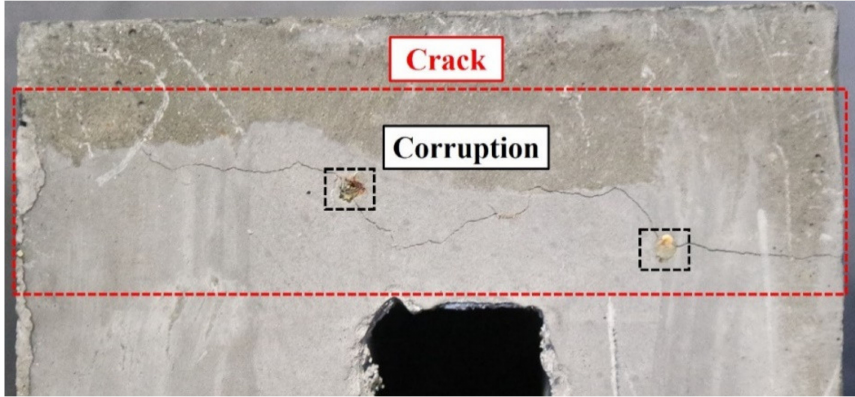
Figure 10. Crack by voltage